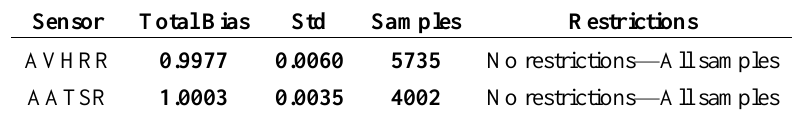
Table 5. Summary of results for all SNO match-up targets for the AVHRR-heritage channel at 3.7 µm based on inter-comparisons with MODIS on AQUA. The total bias is expressed as the relative bias ( i.e. , brightness temperature